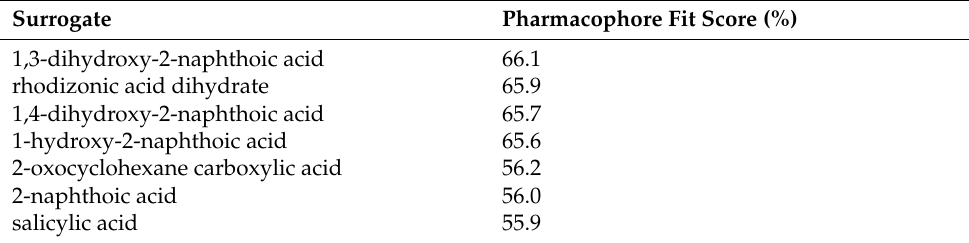
Table 1. Surrogates selected for imprinting as identified by a pharmacophore search. Surrogate